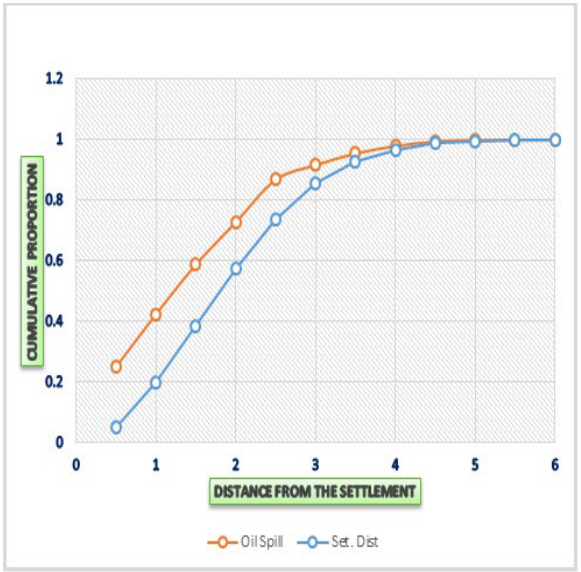
Figure 9. Proximity of spills to the